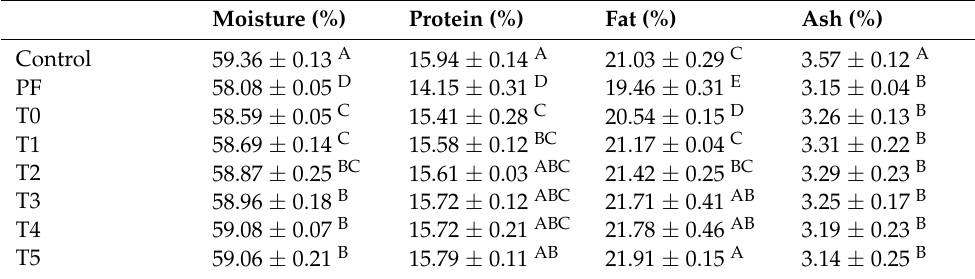
21.91 ± 0.15 A 3.14 ± 0.25